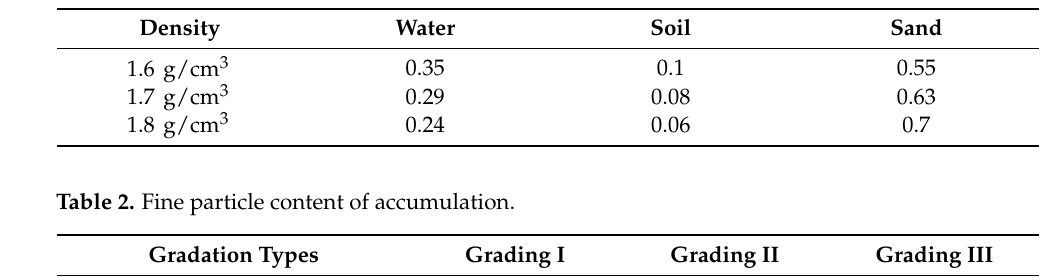
Table 1. Composition of debris flow.